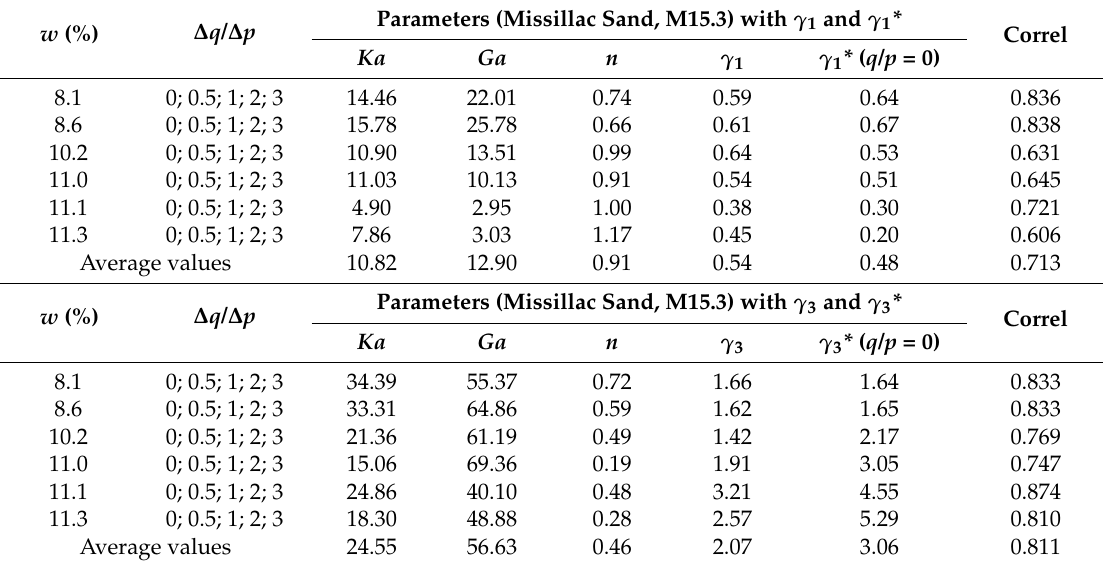
Table 6. Parameter optimization of the modified Boyce model for